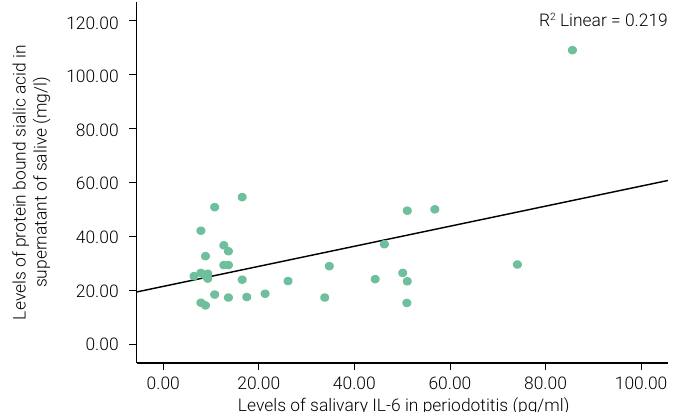
Figure 1. Correlation between salivary IL-6 and protein bound sialic acid in supernatant of saliva of periodontitis